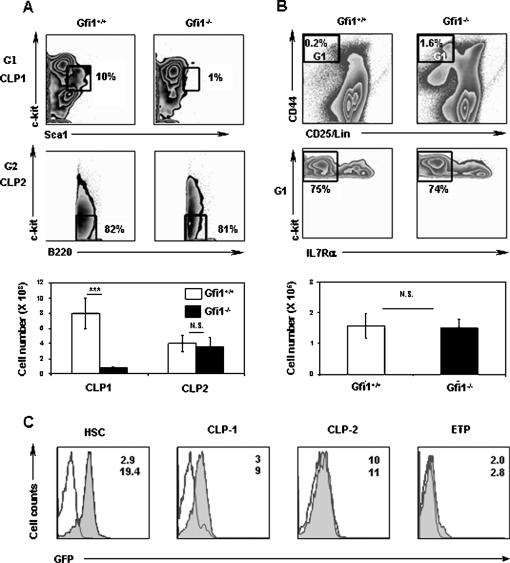
Developmental dichotomy of CLP1 and presumptive CLP2 progenitor cells evidenced by analysis of Gfi1−/− and Gfi1GFP/+ mice.A) FACS plots indicating relative decrease of CLP1 (upper panels) and normal numbers of presumptive CLP2 (middle panels) in Gfi1−/− bone marrow cells. Cells were pregated on Lin−IL7Rα+ cells (upper panels) and Lin−IL7Rα+Sca1+CD19− cells (middle panels), respectively. Bar diagrams indicating absolute numbers of CLP1 and CLP2 cells of Gfi1−/− and Gfi1+/+ mice (lower panel, n = 3 mice). Lineage markers included CD4, CD8, CD11c, CD11b and B220. Flow-cytometric analysis was performed on pooled BM cells from 5 mice. Shown is a representative experiment of 3. B) FACS plots indicating relative increase of ETP in Gfi1−/− thymus. Lin−CD25−CD44+ cells (upper panels) were gated (G1) and analysed for expression of c-kit and IL7Rα (lower panels). Experiments were performed on pooled thymi (n = 5 mice). Bar diagrams indicating absolute numbers of ETP of Gfi1−/− and Gfi1+/+ mice (lower panel, n = 3 mice). The total number of thymocytes was decreased by ∼6 fold in Gfi1−/− mice. Shown is a representative experiment of 3. C) Transcriptional activity of Gfi1 locus in hematopoietic progenitor cells and thymic B cells. Pooled bone marrow cells or thymocytes (n = 5) were analyzed for GFP expression in the following populations: LSK (HSC), Lin−IL7Rα+Sca1lowc-kitlow (CLP1), Lin−IL7Rα+Sca1+c-kit−B220+CD19− (CLP2) and Lin−CD25−IL7Rα−CD44+c-kit+ (ETP). Shaded histograms represent GFP fluorescence in Gfi1+/GFP cells, open histograms represent autofluorescence of Gfi1+/+ cells. The GMFI (Geo Mean Fluorescence Intensity) of Gfi1+/+ (above) and Gfi1+/GFP (below) cells is indicated. Data are representative of 3 independent experiments.